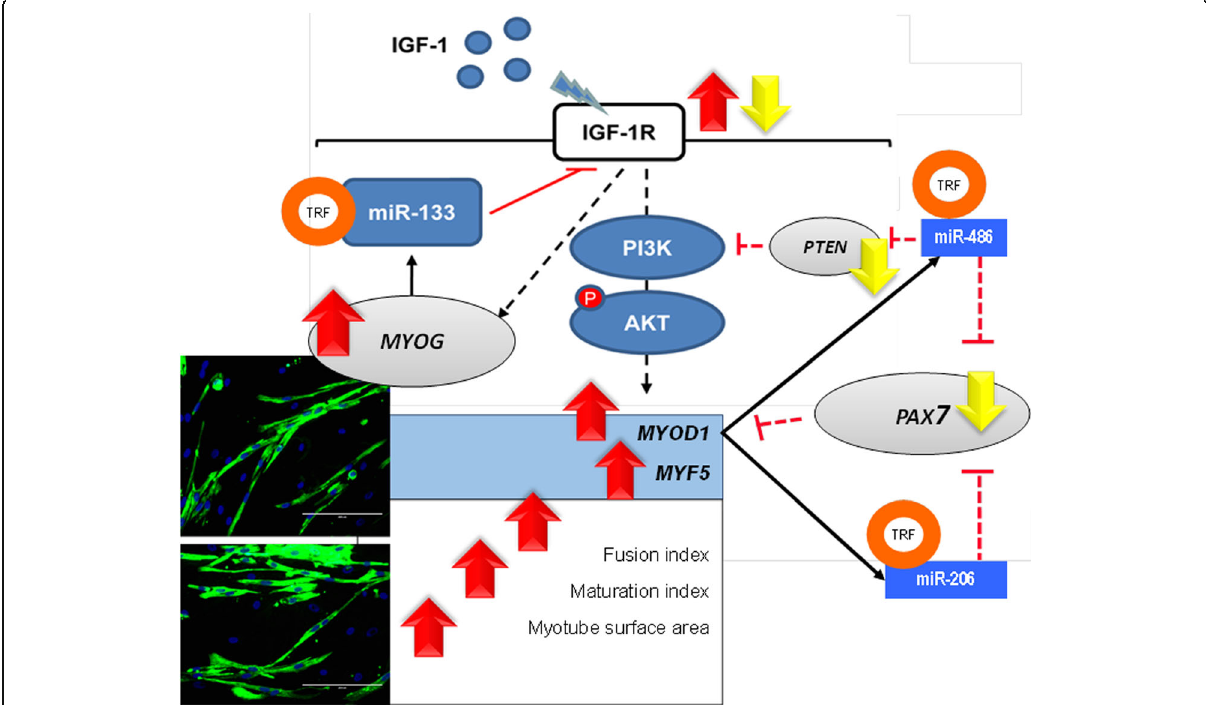
Fig. 8 Modulatory effects of TRF on the expression of myomiRs and myogenic regulatory